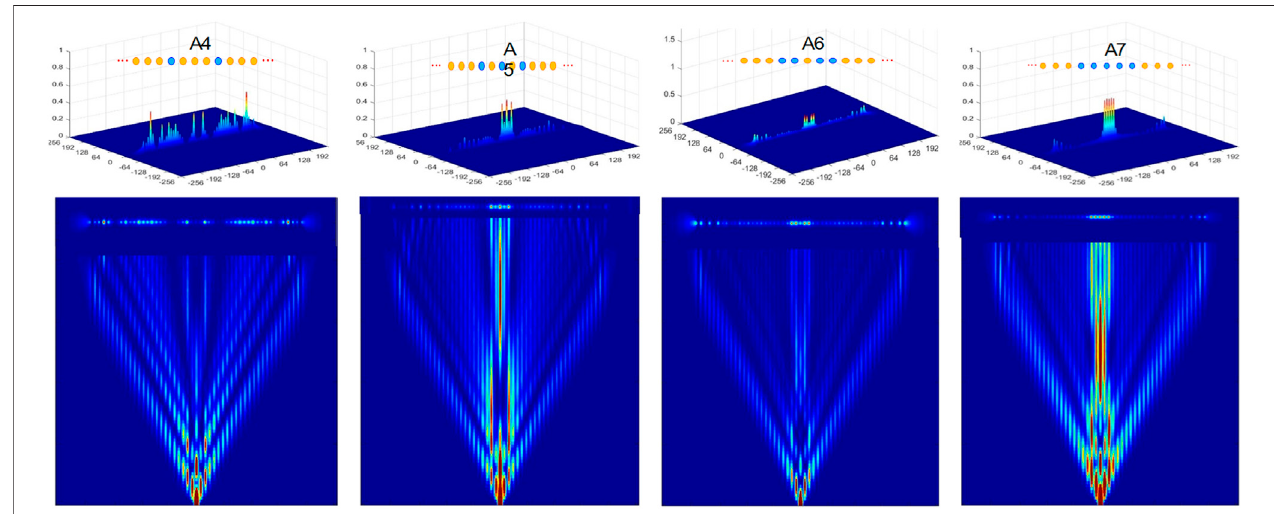
FIGURE4| LightpropagationinBPLs A4 , A5 and A6 ,and A7 ,fromthe left tothe right ,respectively. Lower: top-viewoflightpropagation, Middle: 2Dfront-view, and Upper: 3D front-view of the output photon distributions. Central cores of binary arrays of waveguides is on top of 3D output